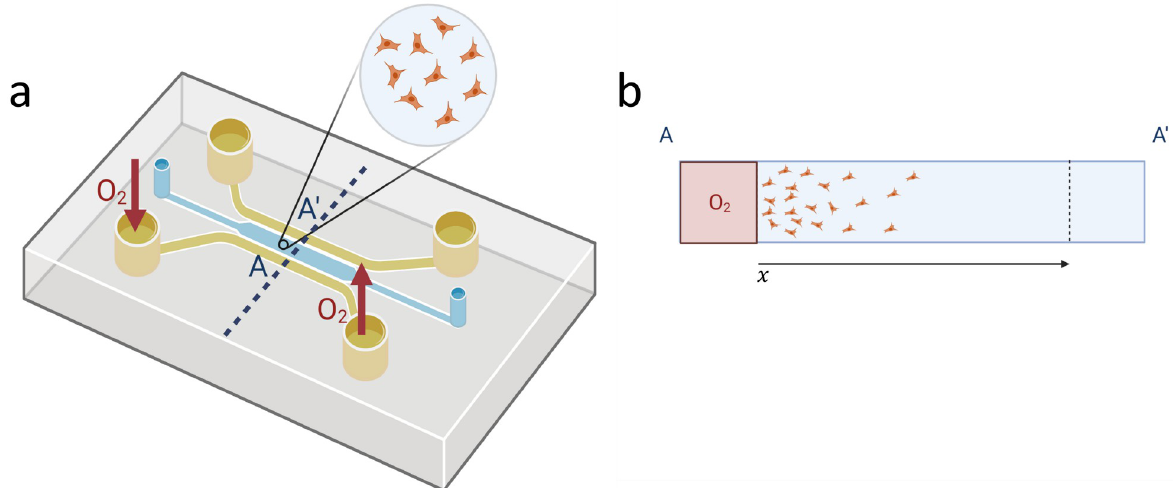
Fig 1. Example of experimental configuration for modeling cell cultures. Due to the long length of the lateral channels with respect to the width of the chamber, the geometry of the model is assumed as one-dimensional being the length the width of the chamber, l . The cell and the oxygen concentrations are associated with continuum fields u 1 = u 1 ( x , t ) and u 2 = u 2 ( x , t ) respectively. At the location of the lateral channels, x = 0, l , boundary conditions for both fields have to be supplied; we have represented a gradient configuration, but it is possible to feed oxygen by the two lateral channels in a symmetric configuration. ( a ) Scheme of the experimental configuration. ( b ) One-dimensional approximation of the cell culture. Created with BioRender.com.